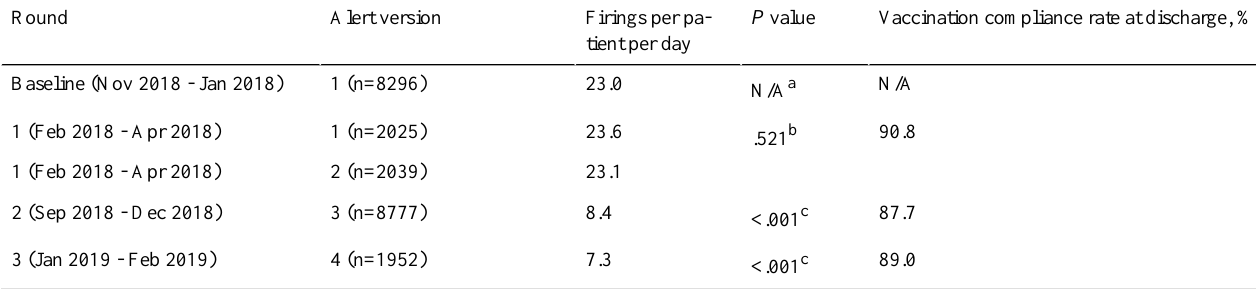
Table 1. Flu alert results.